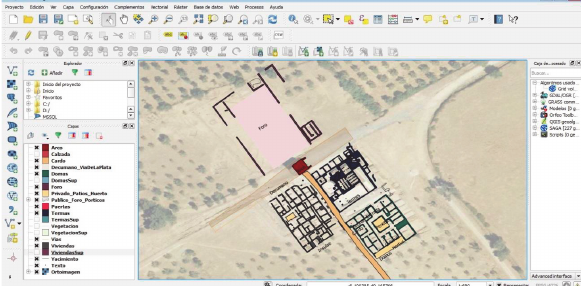
Figure 11. Visualization of the geospatial layers and WMS services in